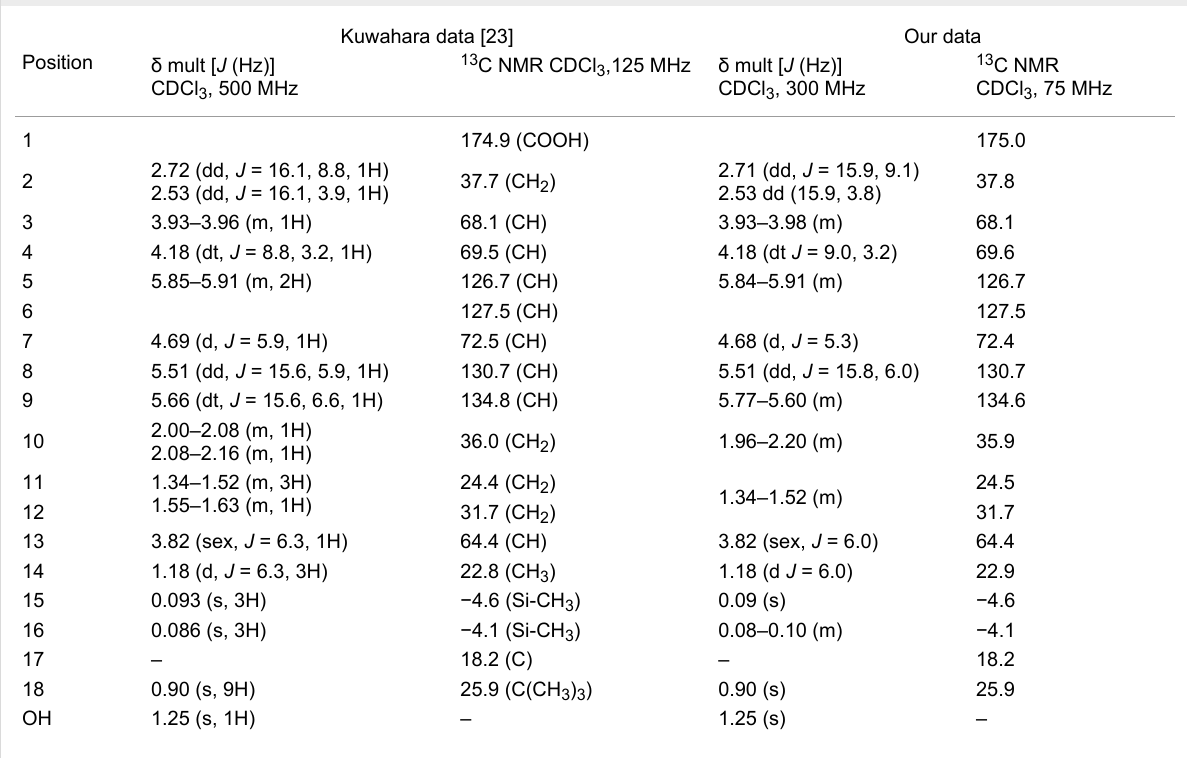
Table 1: Comparision of 1 H and 13 C NMR data of seco acid 4 with earlier data. Position